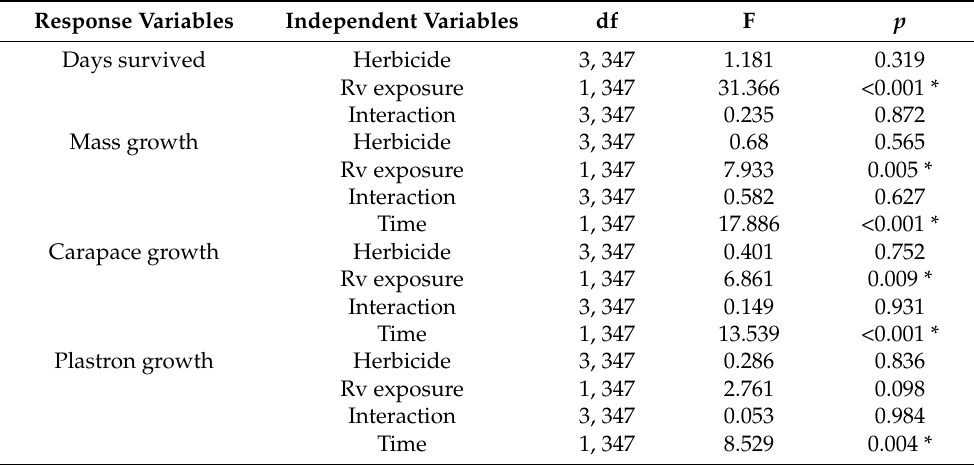
Table 2. Results of GLM analysis with herbicide treatments, ranavirus exposure, and interaction effect between the two variables as fixed factors, and time (weeks 1–5) as a covariate. For herbicide treatments, hatchling turtles ( Trachemys scripta elegans ) were constantly exposed to four chemicals (atrazine, Roundup, Rodeo, and control) during the first 3 weeks of the experiment via water bath exposure. Ranavirus exposure consisted of injecting turtles with 100 uL of virus-infected cell lysate (FV3; 6.3 × 10 4 TCID 50 ) into the pectoral muscles after 1 week of the experiment; controls were injected similarly with cell culture